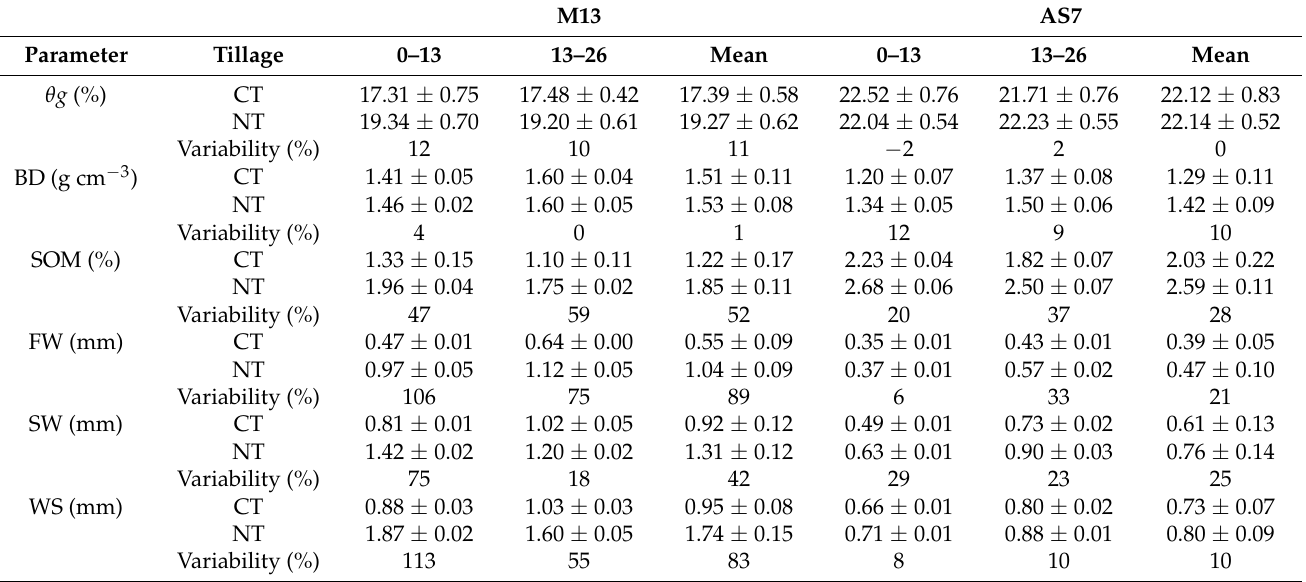
Table 3. Physical characteristics of M13 and AS7 (mean ± standard deviation).